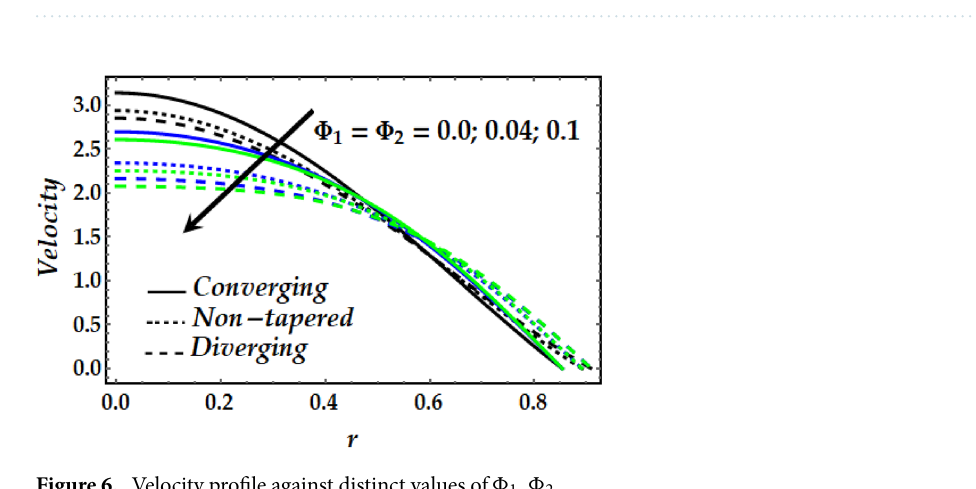
Figure 5. Velocity profile against distinct values of δ .